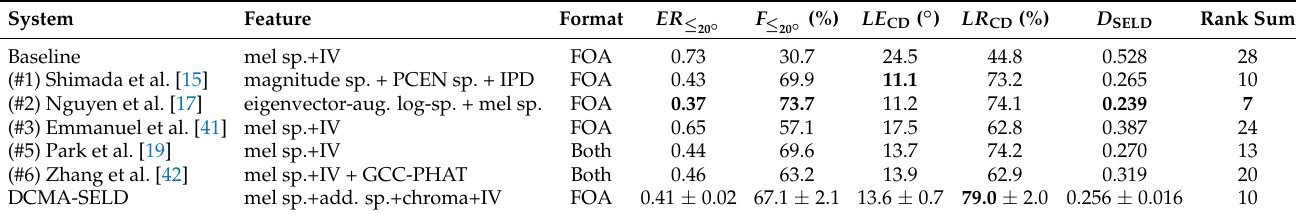
Table 7. Performance of our DCMA-SELD and the models submitted to the DCASE2021 challenge on the TNSSE 2021 development dataset. The baseline system in the challenge corresponds to the modified version of the SELDnet in [40]. The numbers after # denote the rank of the model in the challenge. “Rank sum” represents the sum of the rankings of the four metrics used as the challenge ranking evaluation method. The highest performance in each metric is indicated in